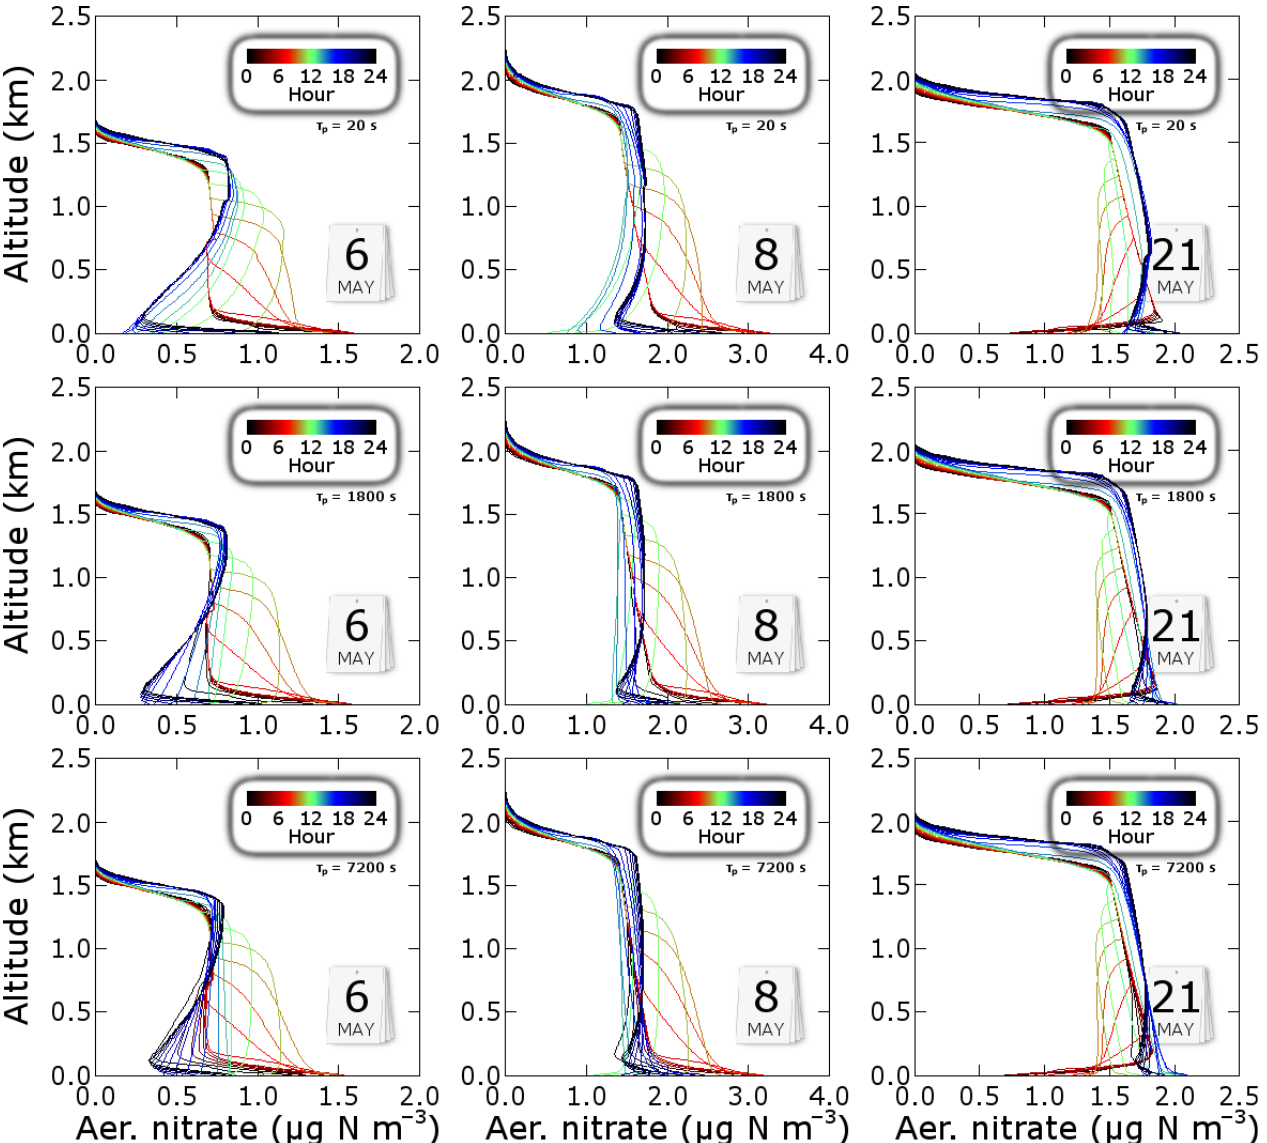
Fig. 6. Modelled aerosol nitrate profiles with partitioning timescales of 20s (top panels), 1800s (middle panels) and 7200s (bottom panels), for 6 May (left), 8 May (middle) and 21 May (right). Each panel contains twenty-four profiles, one per hour, and the colour indicates the